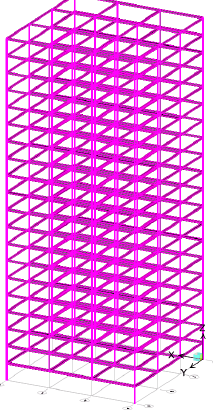
Figure 13. Frame structure of 20 stories.